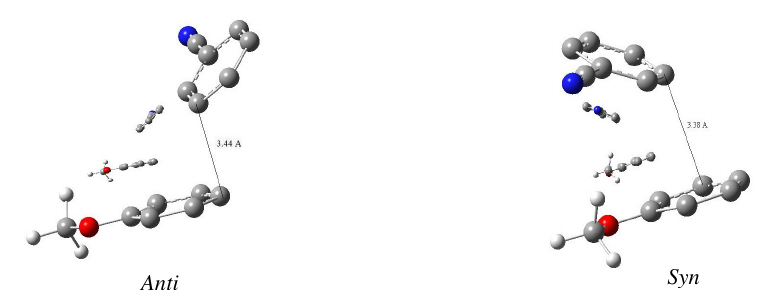
Figure 3 . Stereo view of substituted benzyl and phenyl rings in stacked conformers of model